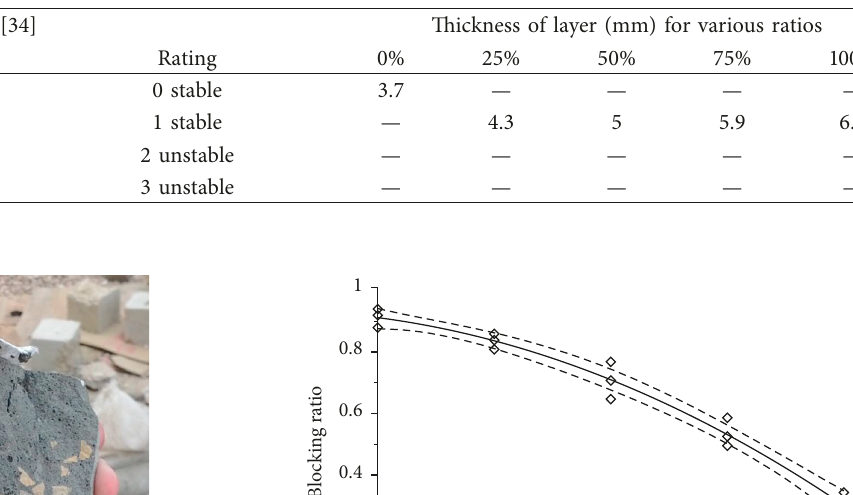
Table 6: The depth of the mortar layer as measured by the segregation probe.